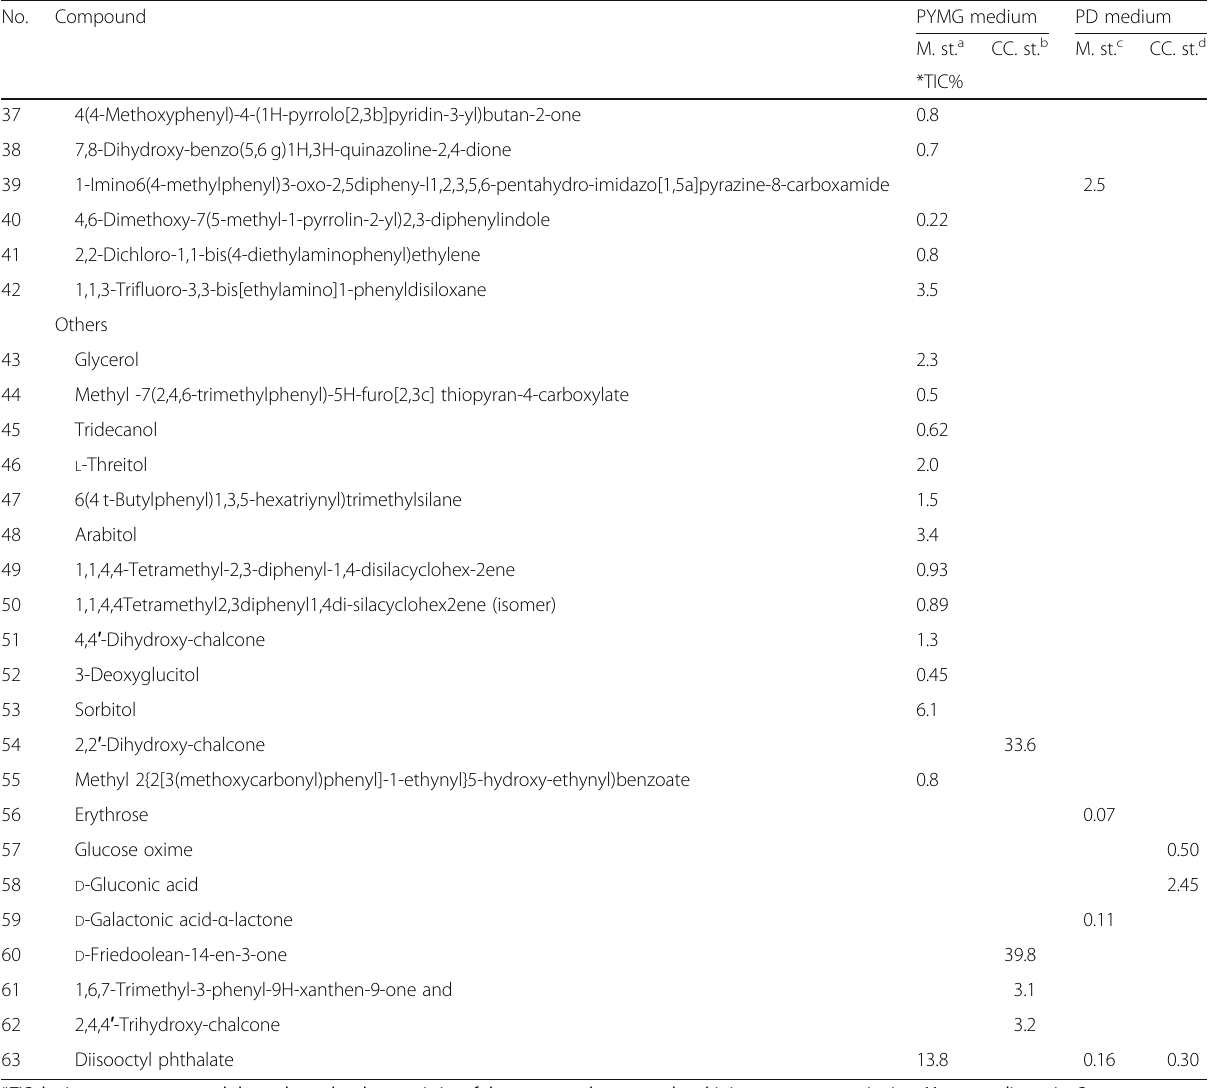
Table 1 Chemical composition assessed by GC/MS analysis for fungal extracts with high antimicrobial activities from different media for Aspergillus unguis SPMD-EGY (Continued)